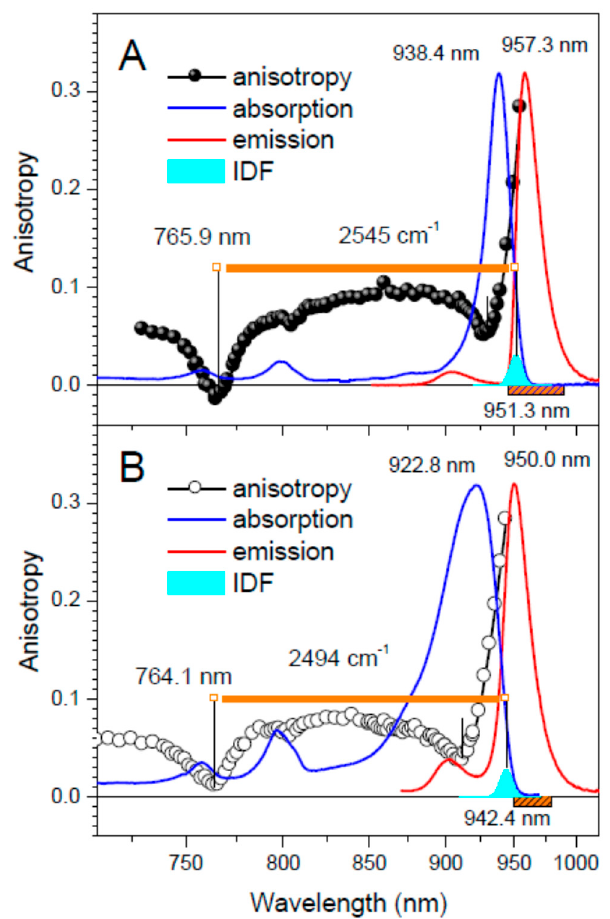
Figure 2. Fluorescence anisotropy excitation spectra of Ca-LH1-RC ( A , black balls) and LH1-RC ( B , black open rings) complexes from Tch. tepidum along with the respective IDF (cyan), absorption (blue line), and fluorescence (red line, excited at 407 nm) spectra recorded at 4.5 K. The weak fluo- rescence bands visible around 914 nm is due to contamination of the samples by trace amounts of peripheral LH2 complexes. See caption of Figure 1 for other relevant comments.